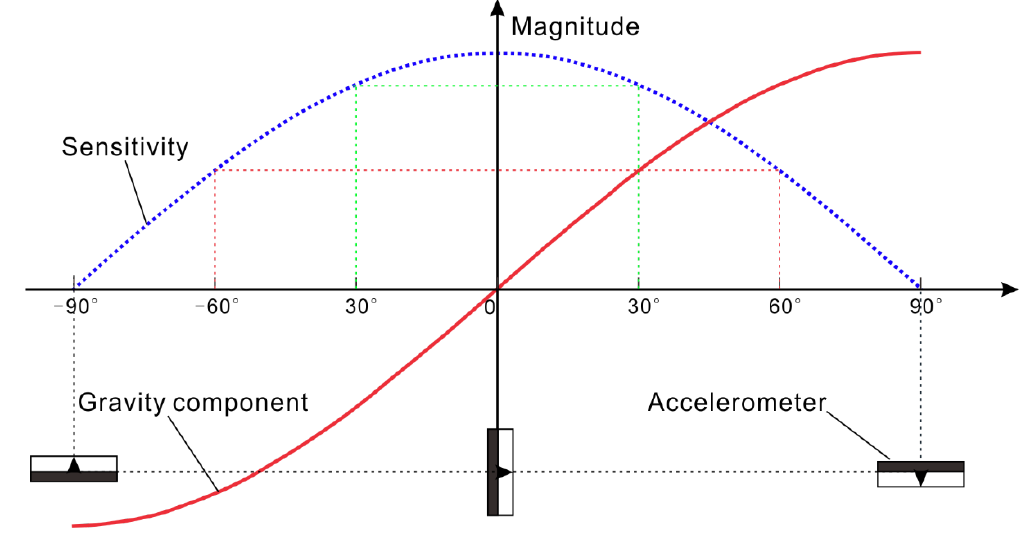
Figure 14. Sensitivity versus angle of accelerometer.